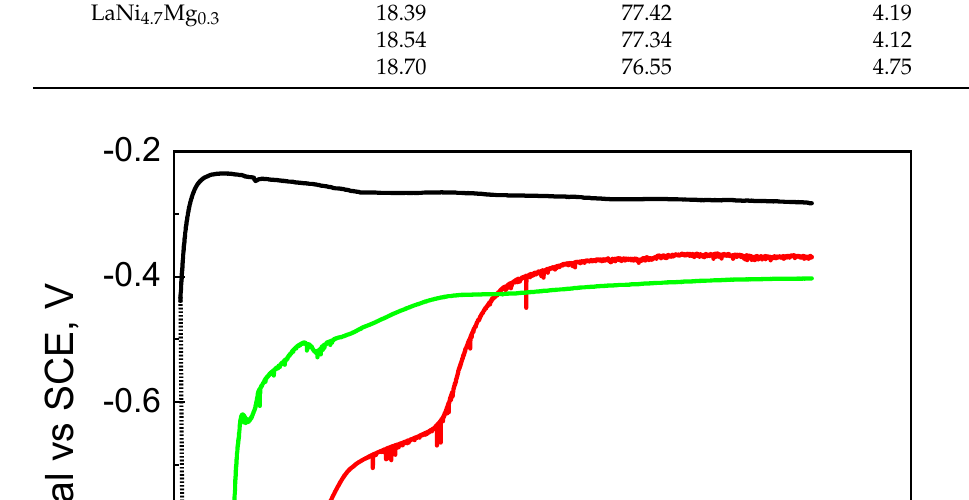
Figure 2. OCP changes for LaNi 5-x Mg x alloys (x = 0, 0.2, and 0.3) recorded for 66 h. Based on the conducted E OCP measurements, we concluded that the alloys containing